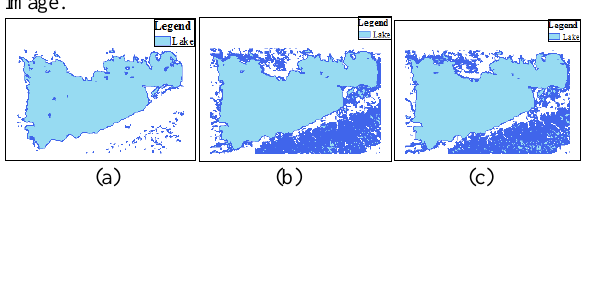
Figure 9. Two forms of